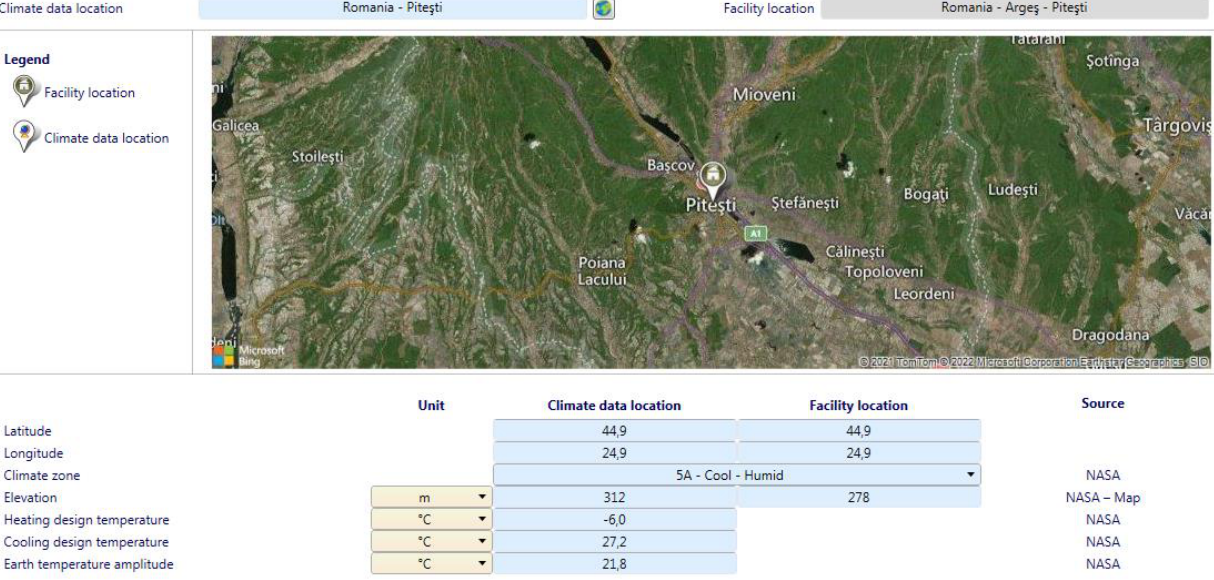
Figure 1. Coordinates and place of PV area.